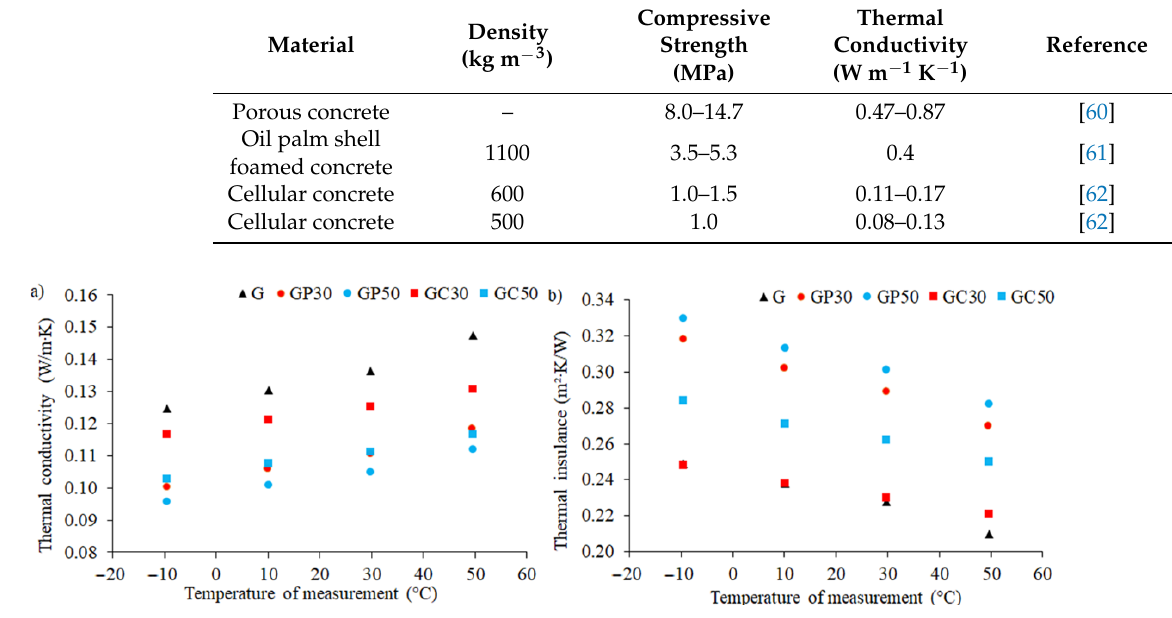
Table 6. Properties of concrete with porous structure according to different authors.